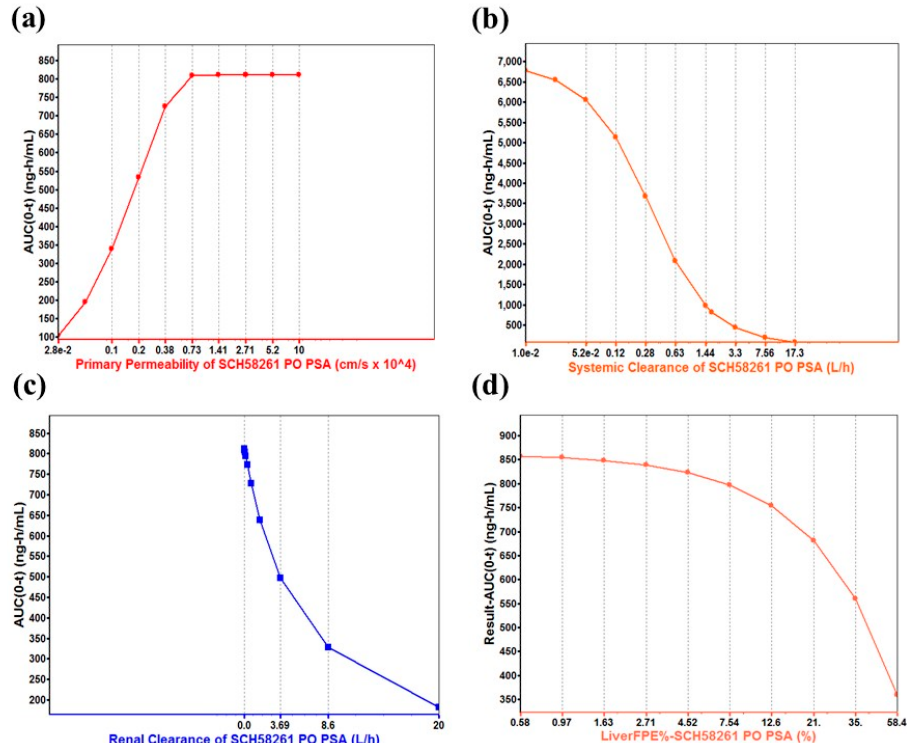
Figure 6. The parameter sensitivity analysis (PSA) of four factors that have significant effects on SCH 58261 AUC last after oral administration in rats. ( a ) Permeability of SCH 58261, ( b ) systemic clearance of SCH 58261, ( c ) renal clearance of SCH 58261, and ( d ) liver first-pass effect (FPE)% of SCH 58261.